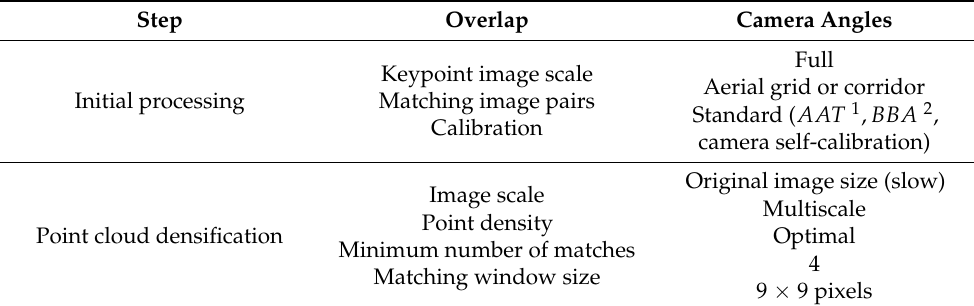
Table 4. Processing settings in Pix 4D mapper.